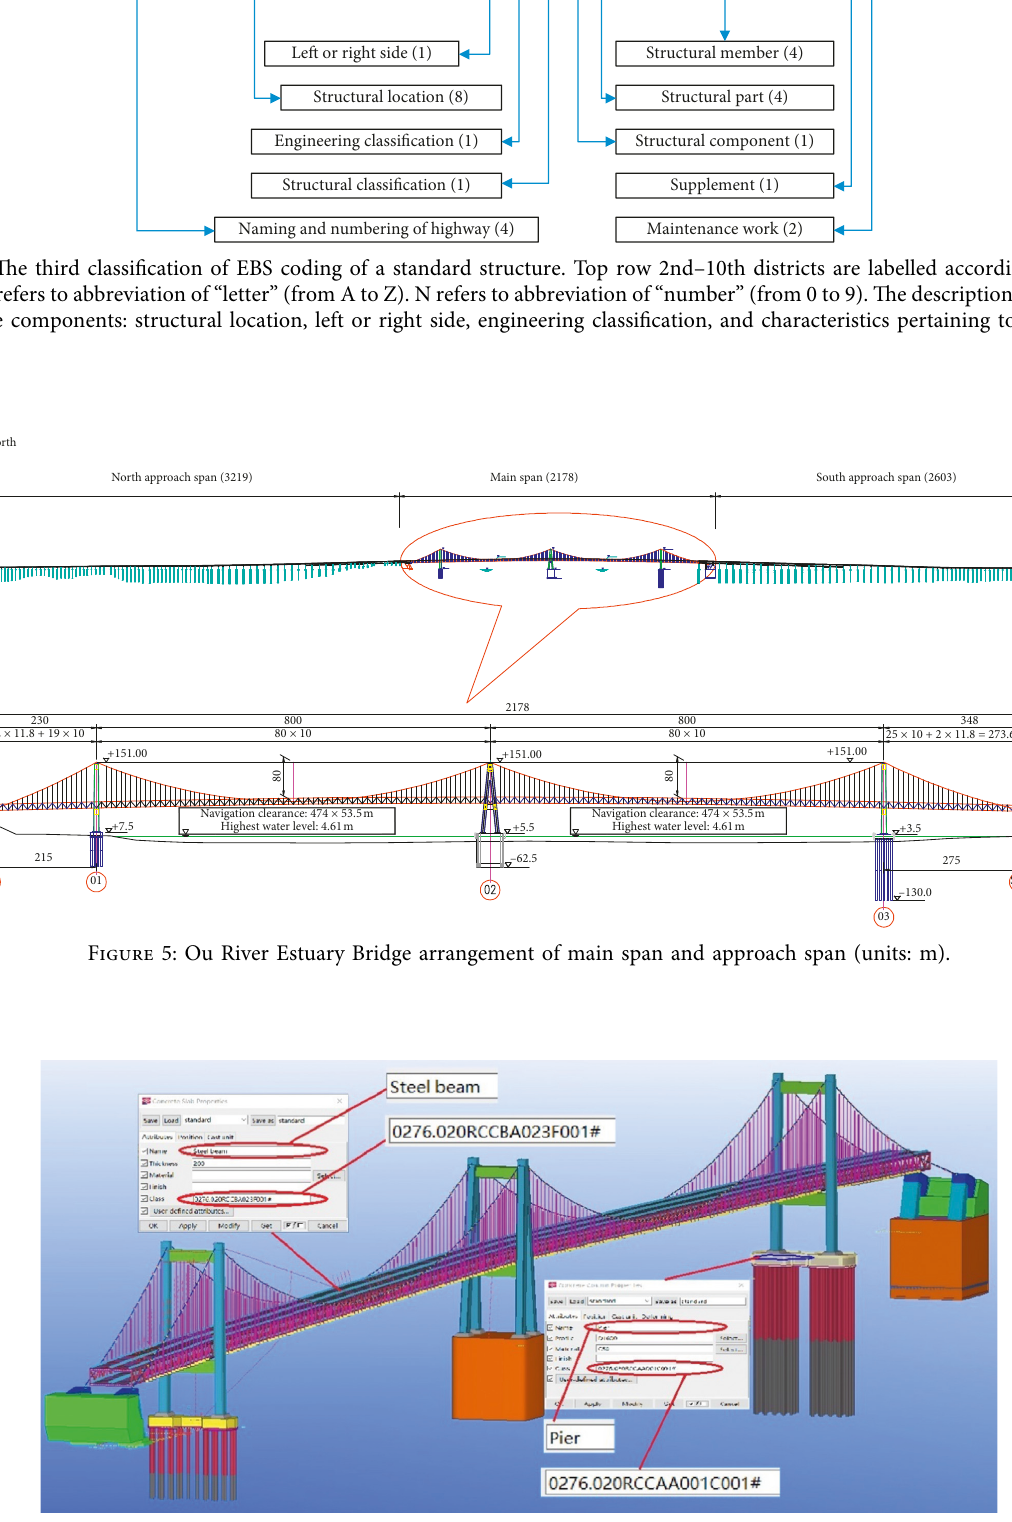
Figure 6: Typical EBS coding results of the Ou River Estuary main span